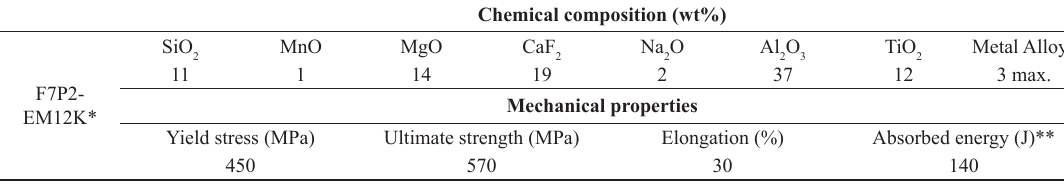
Table 3: Chemical composition and mechanical properties of the flux and electrode for SAW.